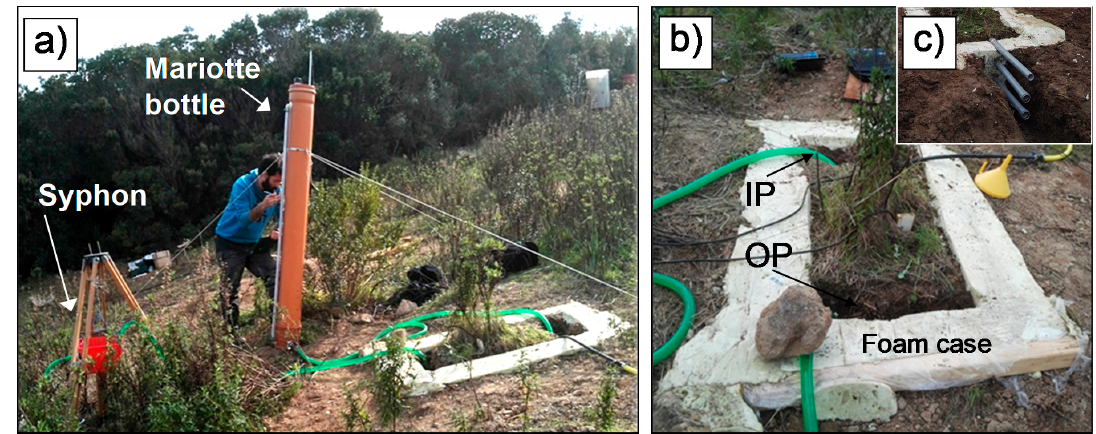
Figure 1. ( a ) Field equipment to determine lateral saturated soil hydraulic conductivities in the monoliths MA, MB and MC; ( b ) soil monolith encased with polyurethane foam, with signed inflow (IP) and outflow (OP) pits; ( c ) spillway pipes inserted in the OP foam of the monolith MD to set the water level and collect the